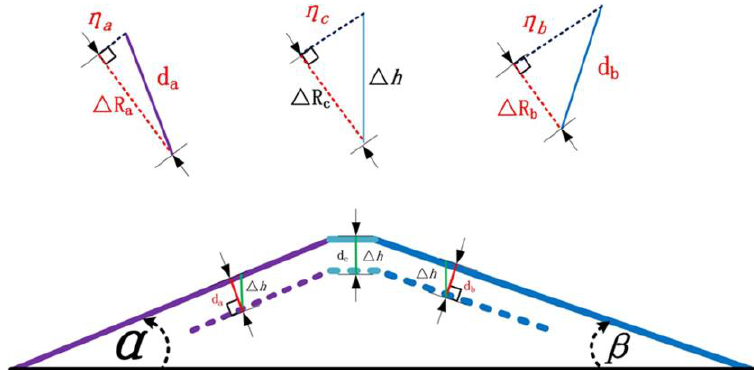
Figure 3. The dam surface vertical deformation projecting in the radar range direction.